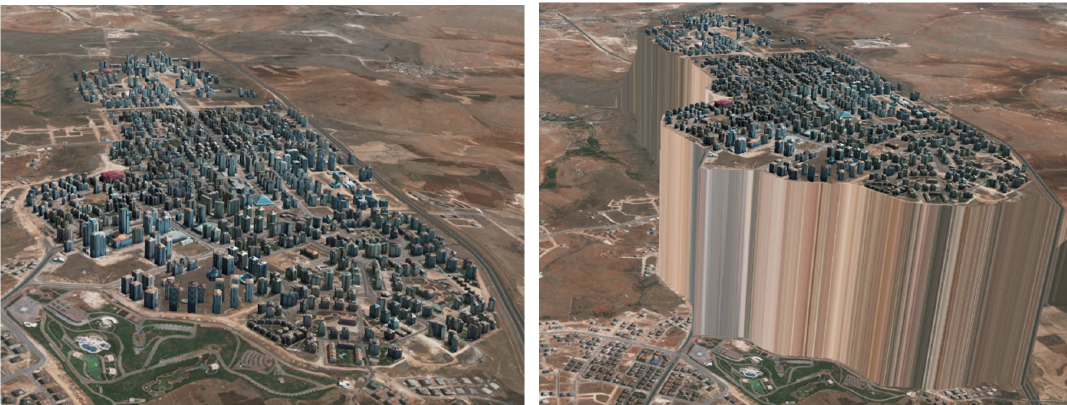
Figure 13. An example of Cesium World Terrain merged ( left ) and unmerged ( right ) with the high-resolution DTM and with the textured LoD2 model in the study area.